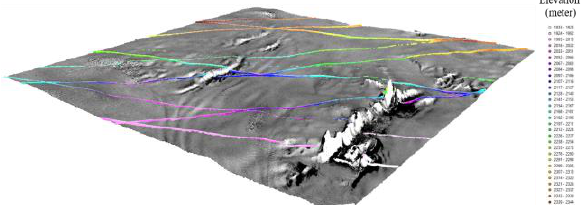
Figure 5. 3D visualization of the ASTER DEM and ICESat data.